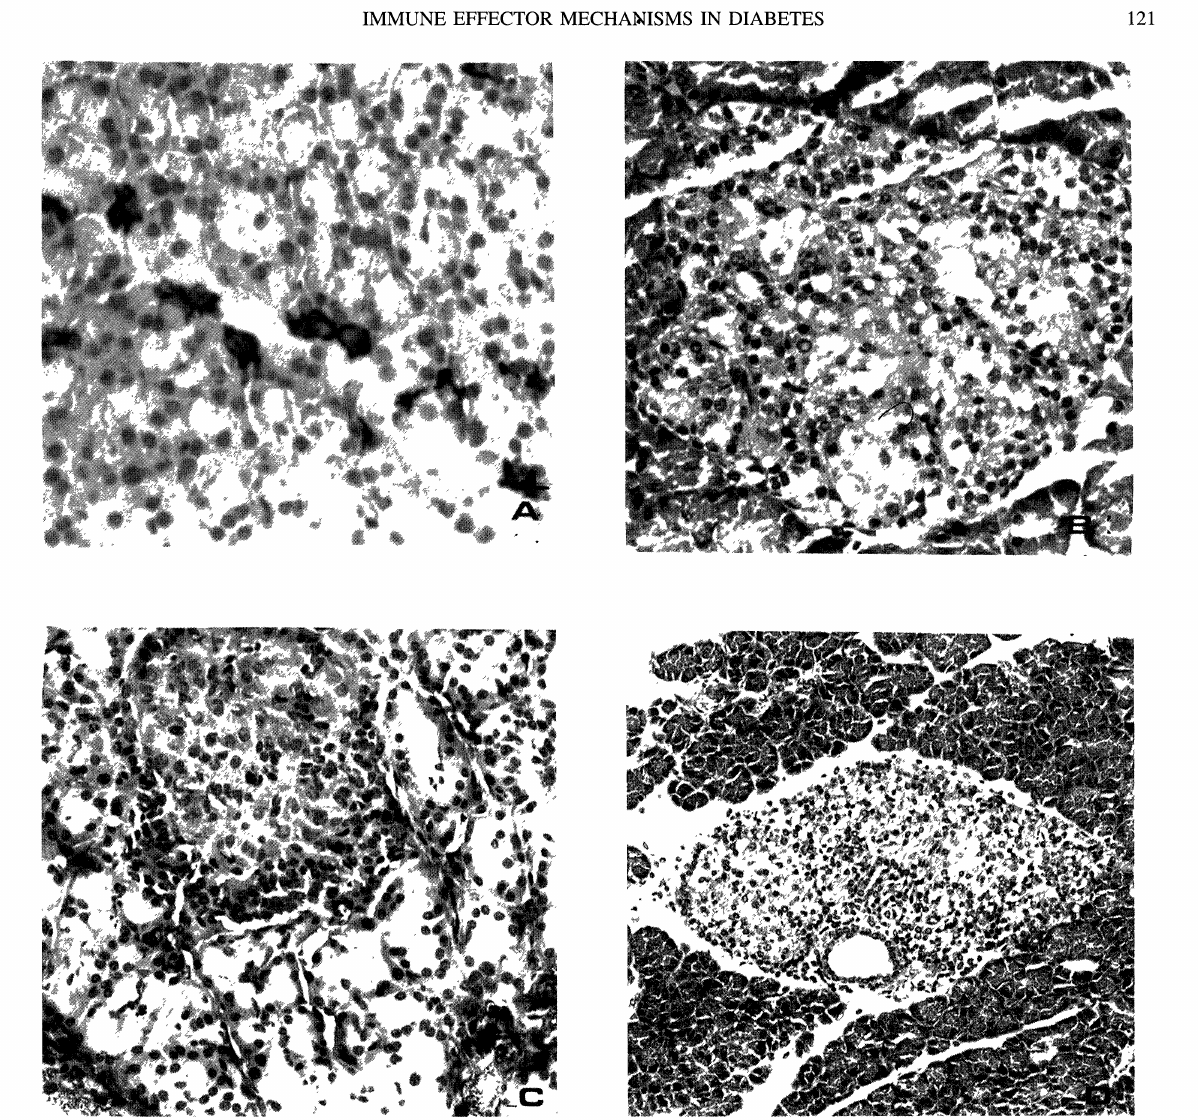
FIGURE MLD-STZ diabetes in susceptible DA rats. (A) Early influx of macrophages: ED-1 positive cells by day 6 after disease induction (PAP). (B) Difuse mononuclear infiltrate in the islet by day 31 after MLD-STZ treatment (HE). (C) CD4 cells in and around the islet by day 10 after MLD-STZ-diabetes induction (W3/25 mabs, PAP). (D) Mononuclear cell infiltrate in the islets 10 days after inititation of MLD-STZ + IFN-T treatment (see text) (HE).